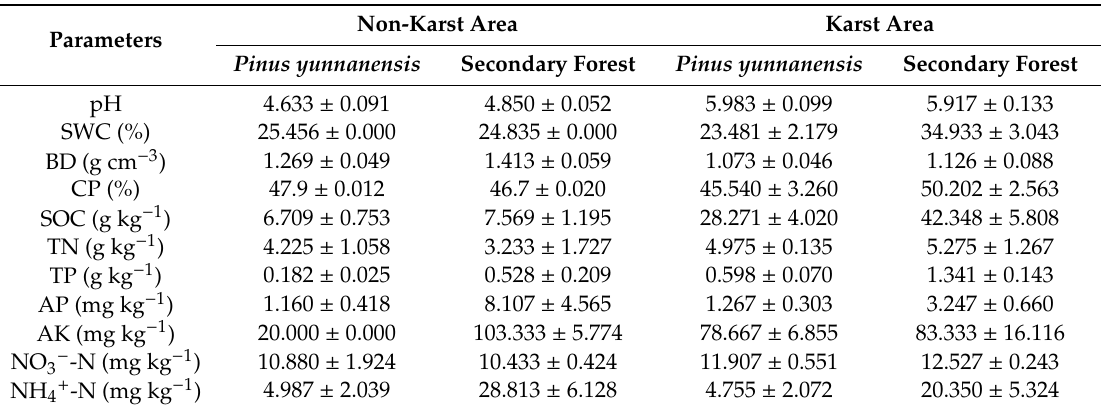
Table 2. The mean values of the soil physicochemical properties of two vegetation types in non-karst and karst areas of southern